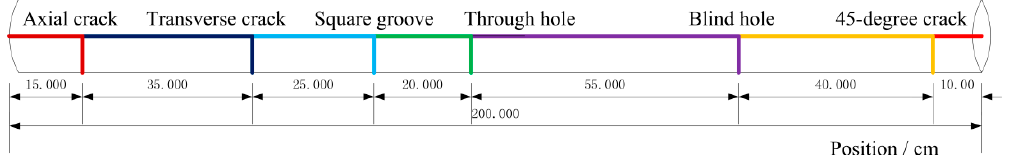
Figure 8. Locations of defects in the laboratory pipeline.